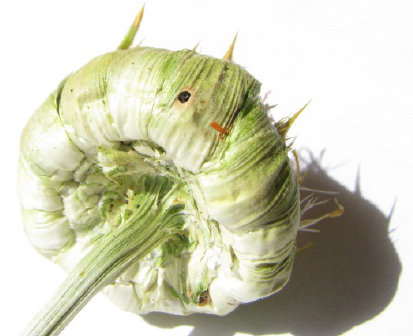
Fig. 11. Adult of Acanthiophilus helianthi